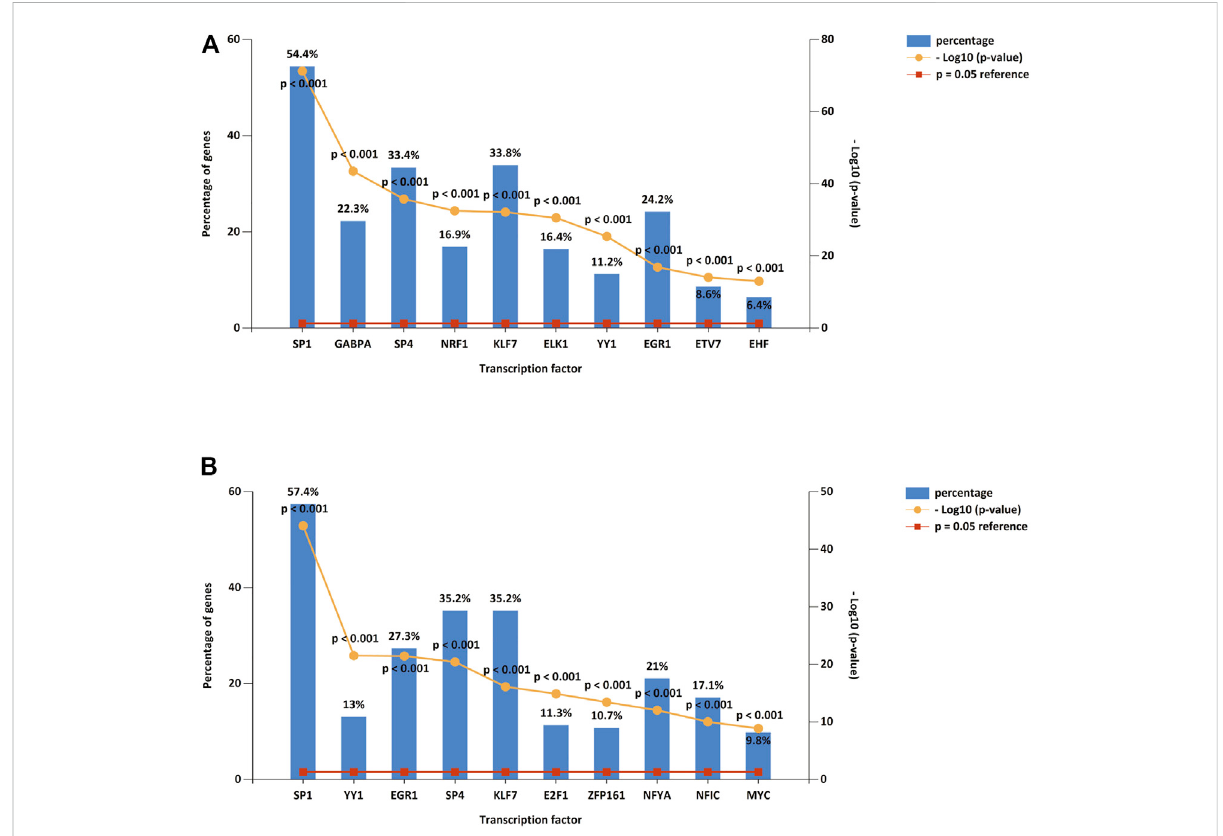
FIGURE 3 DE-miRNA upstreamTFs. (A) Top 10 TFs of down-regulated DE-miRNAs. (B) Top 10 TFs of up-regulated DE-miRNAs. TF: transcription